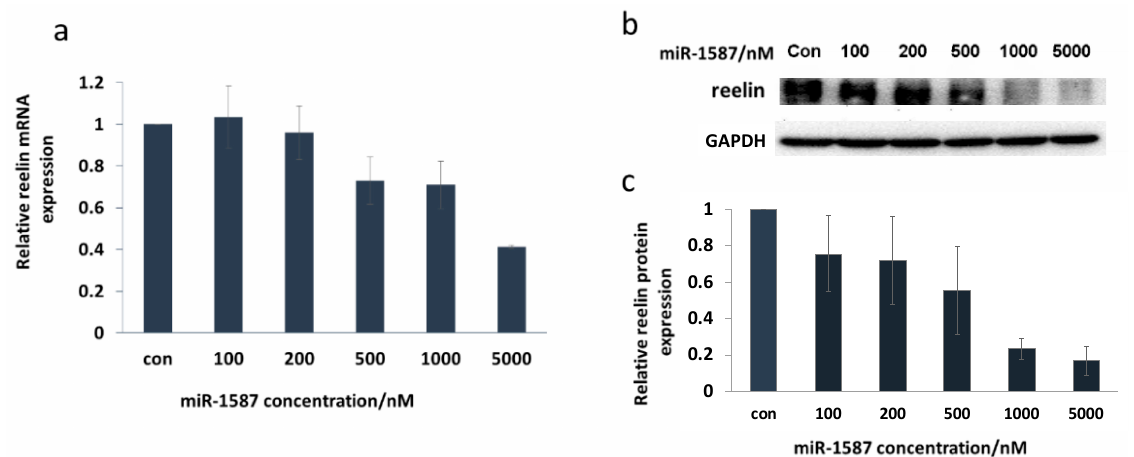
Figure 4. Reelin was down-regulated by miR-1587 in HeLa cells. ( a ) q-RT-PCR results for reelin, with β -actin as a control. ( b ) Western blot of reelin, with GAPDH as a control. ( c ) Histogram of reelin protein levels at different miR-1587 concentrations. Data were obtained through two independent sets of HeLa cells and the regulation results of each set were applied for analysis.